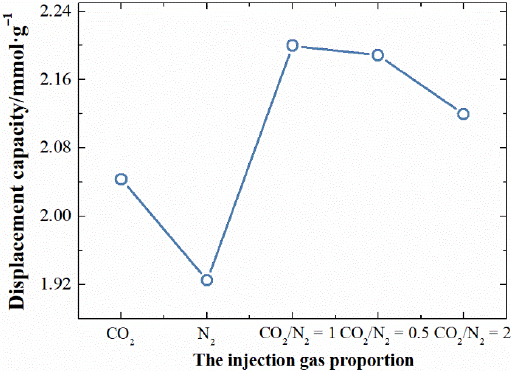
Figure 15. The terminal displacement capacity of CH 4 as a function of the gas proportion.